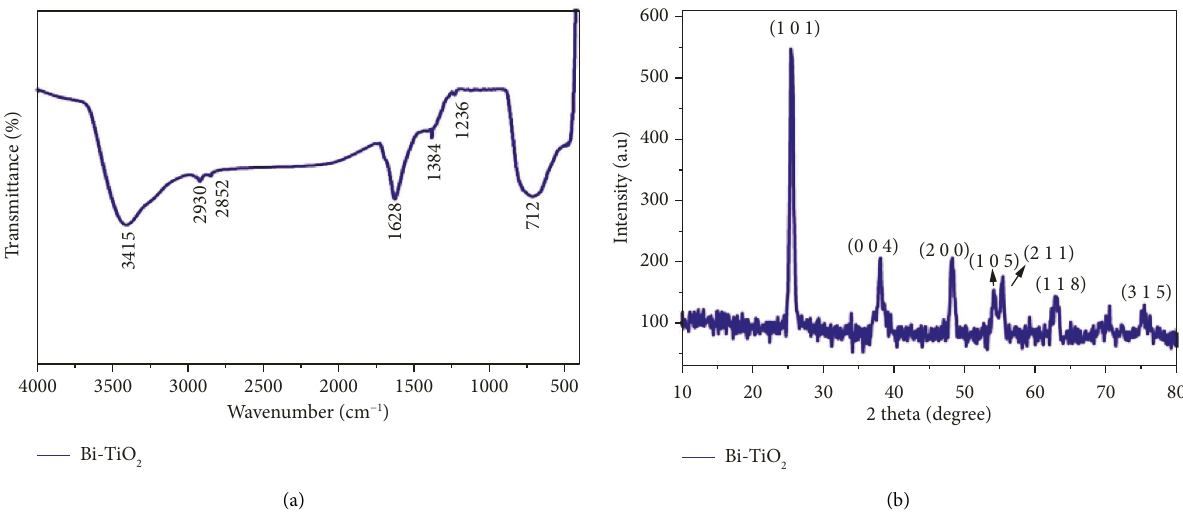
Figure 2: (a) FTIR spectrum and (b) XRD pattern of synthesized Bi-TiO